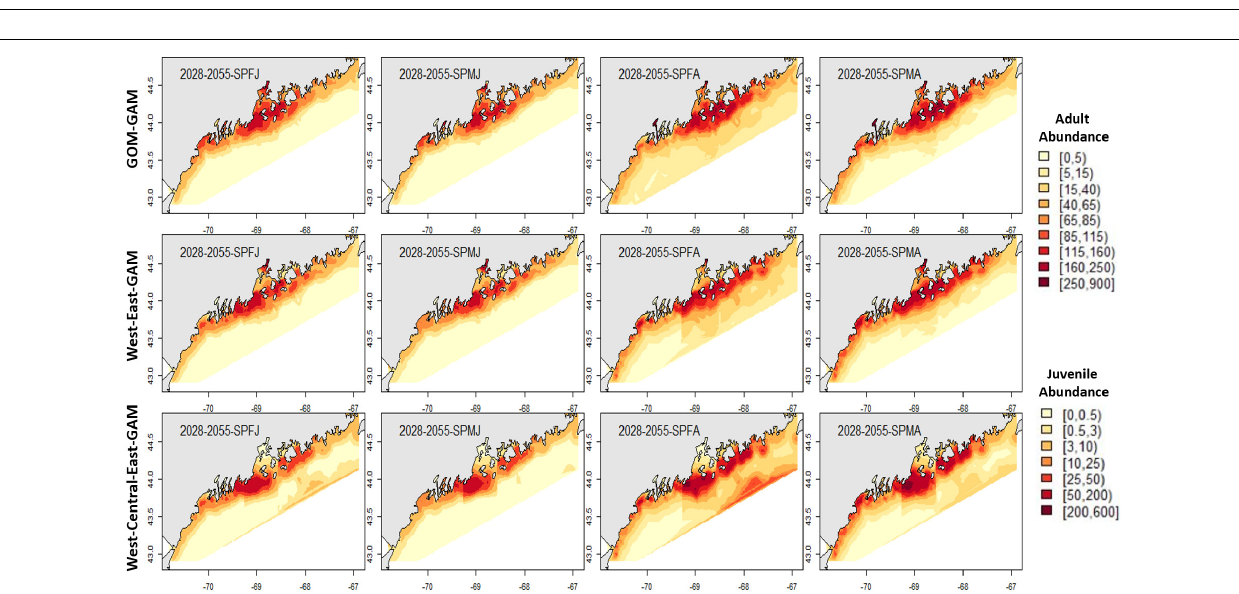
FIGURE 6 | 2017 spring American lobster estimated spatial distribution. See Figure 4 for figure details.